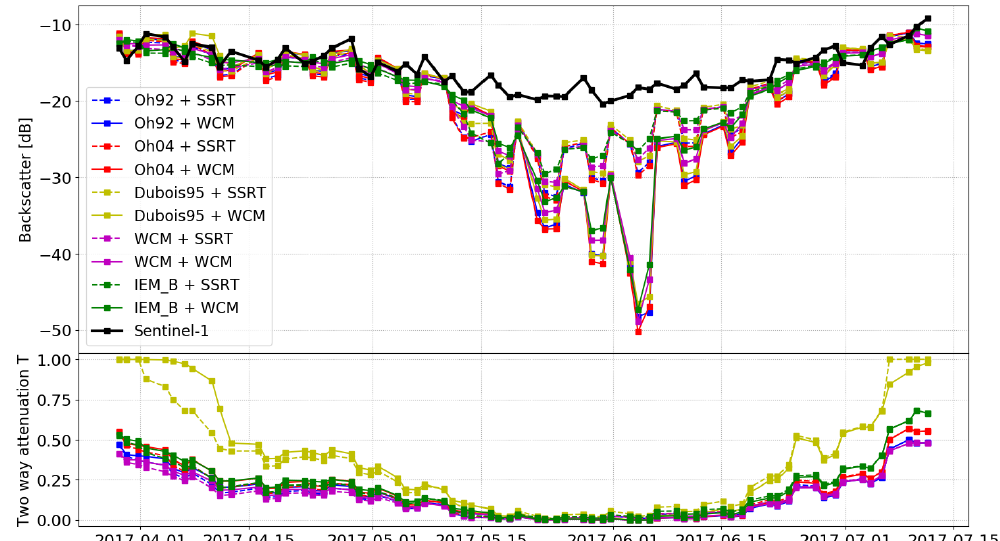
Figure 7. Model results (wheat field 508, non-static parameter) of ground contribution to total backscatter for different model combinations (different colors) with Sentinel-1 VV polarized total backscatter (black line) as reference ( top ). Temporal evolution of model component two way attenuation by the canopy T ( bottom ).